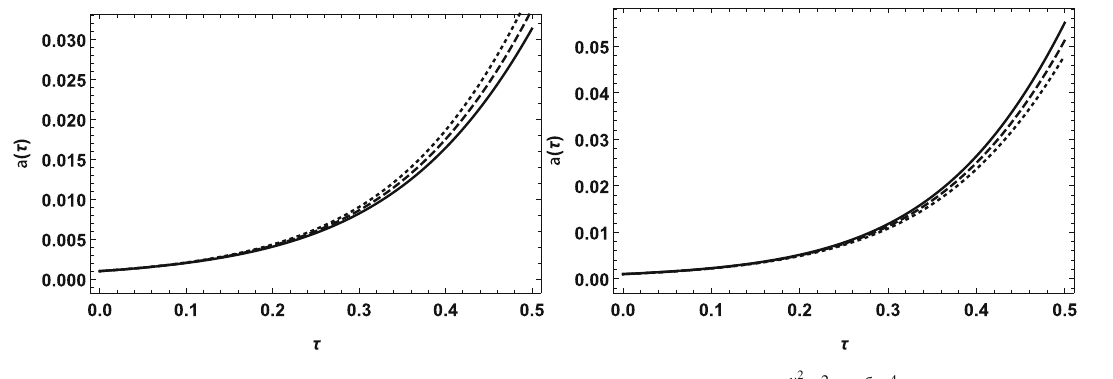
Fig. 2 Above plots show the scale factor versus dimensionless time. Left plot is for V (ϕ) = − ν 2